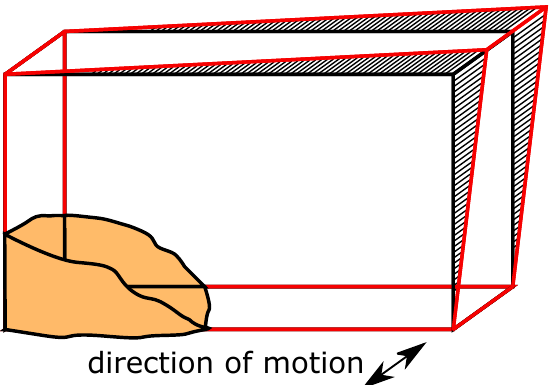
Figure 7. 3 rd modal shapes of 7-story RC-building identified by using